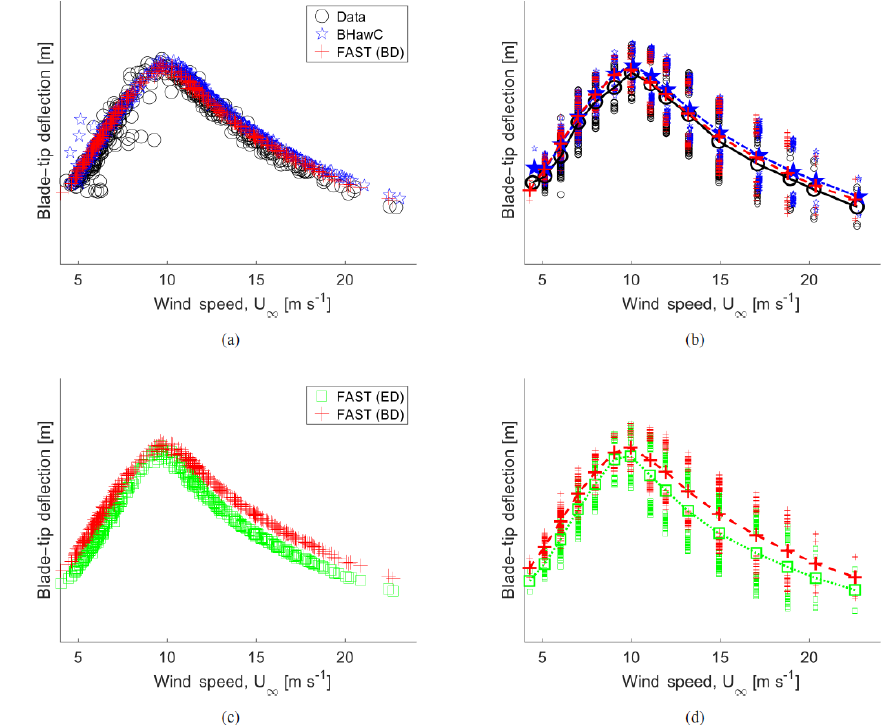
Figure 5. Blade out-of-plane tip deflections. (a) Individual 10min averages from experimental data, BHawC, and FAST (BD). (b) Binned averages of data in (a) are denoted by points connected by lines; the scatter above and below these data denotes plus or minus 1 standard deviation, respectively, of the individual 10min data sets in that bin. (c) Individual 10min averages from FAST (BD) and FAST (ED). (d) Binned averages of data in (c) are denoted by the points connected by lines; the scatter above and below these data denotes plus or minus 1 standard deviation, respectively, of the individual 10min data sets in that